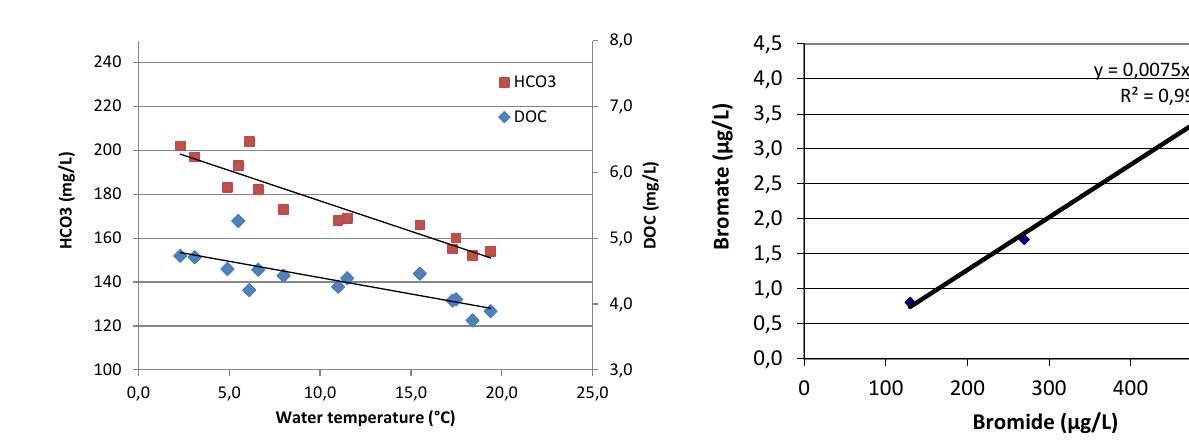
Figure 8. Bromate formation as function of bromide concen- tration at setting 6 / 1 . 5 (water temperature 1.6 ◦ C, bicarbonate 201mgL − 1